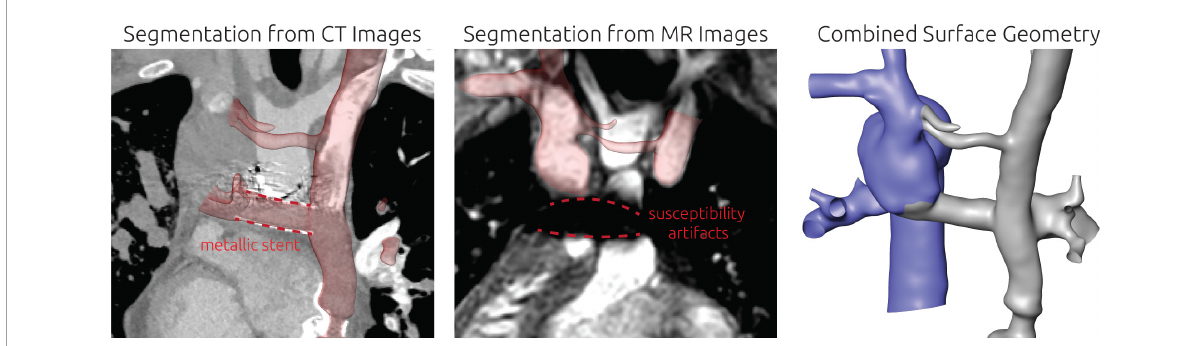
FIGURE6 Detailed overview of the segmentation strategy for the second patient. The left and mid panel show the segmentation from CT and CMR images respectively. The right panel shows the final surface geometry that was reconstructed by combination of both segmentations. Tissue highlighted in blue was reconstructed from CMR images, whereas the remaining tissue was reconstructed from CT images. Additionally, the location of a metallic stent in the TCPC is highlighted in the CT images together with the resulting magnetic susceptibility artifacts during CMR